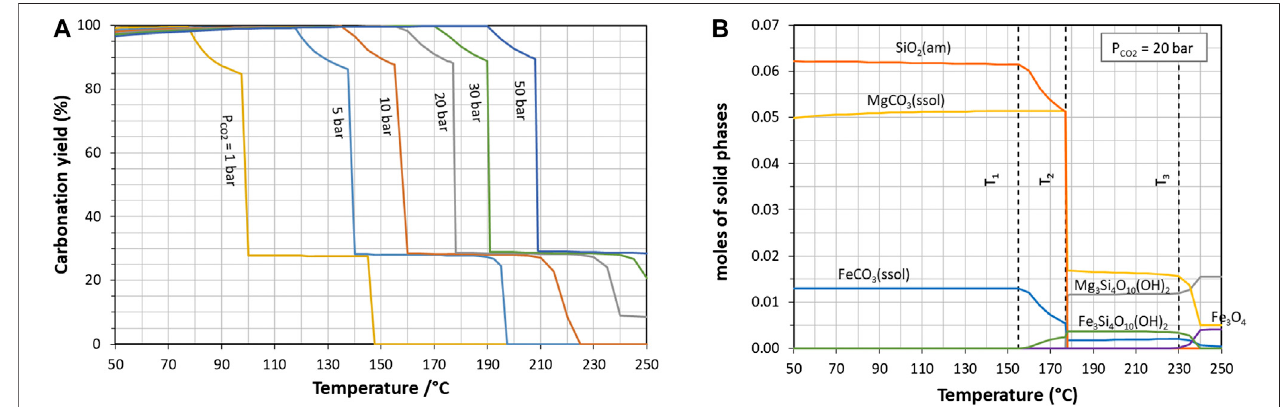
FIGURE6| Effectoftemperatureonthecarbonationofslagdescribedassystem1(majormetaloxidesonly): (A) carbonationyieldatdifferentCO 2 partialpressures and (B) solid carbonation products at 20 bar of CO 2 .